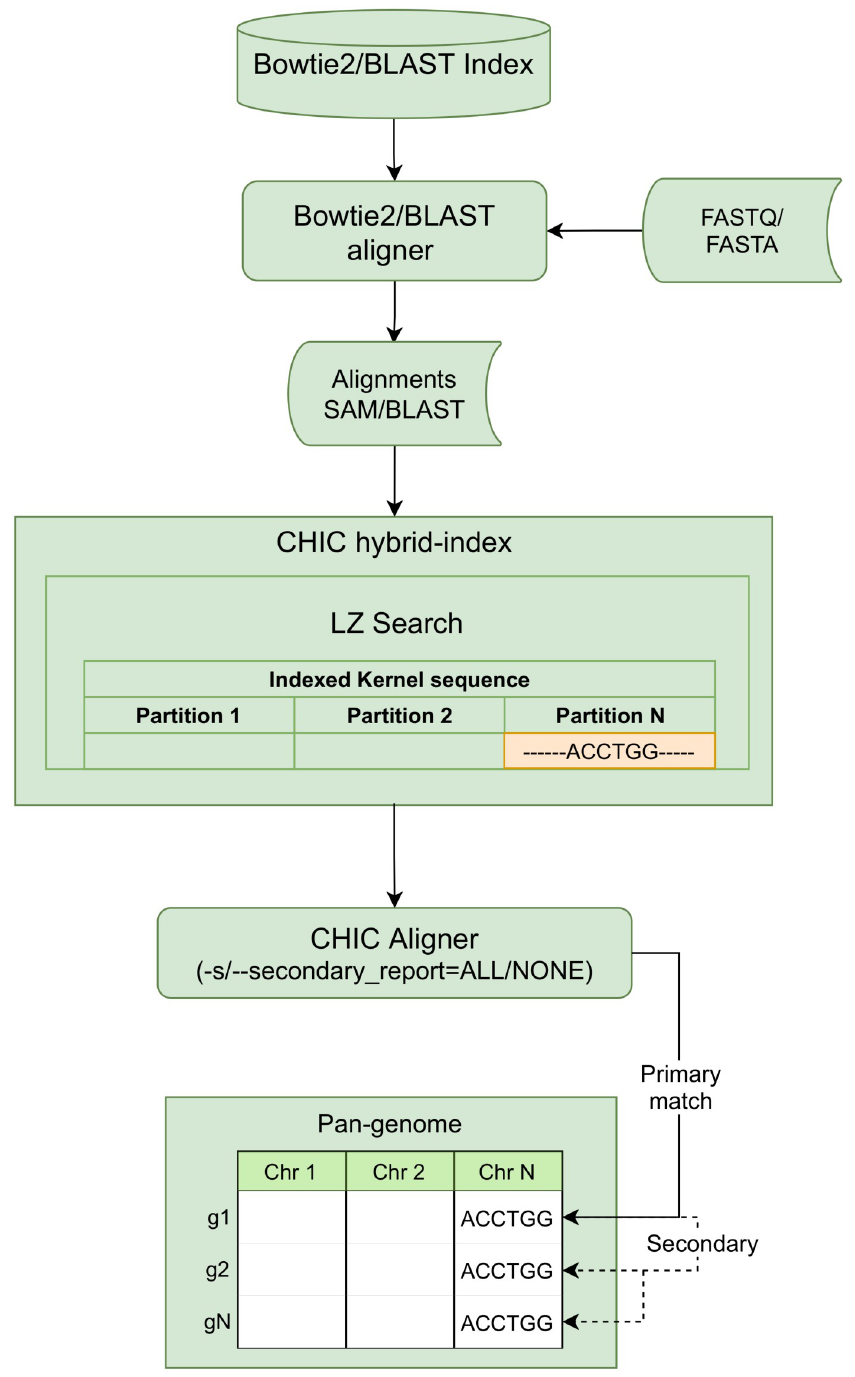
Fig 4. Sequence alignment with